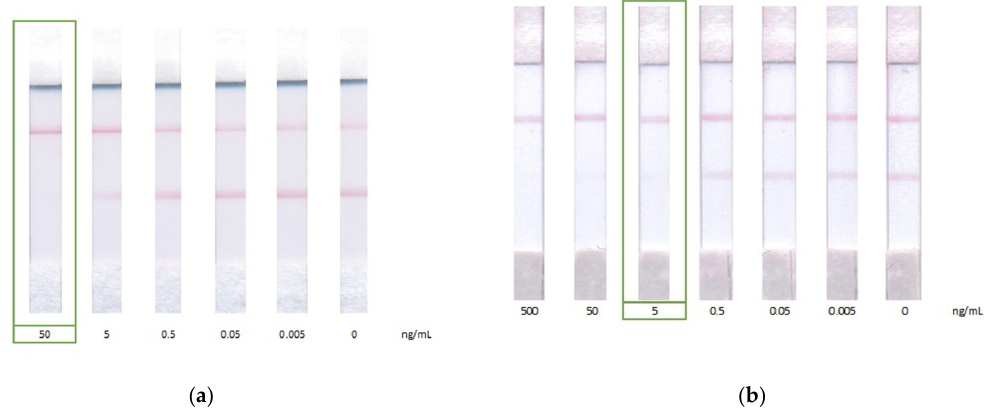
Figure 5. LFIA of CAP by ( a ) standard competitive scheme and ( b ) double competitive scheme. The appearance of test strips after the assays.